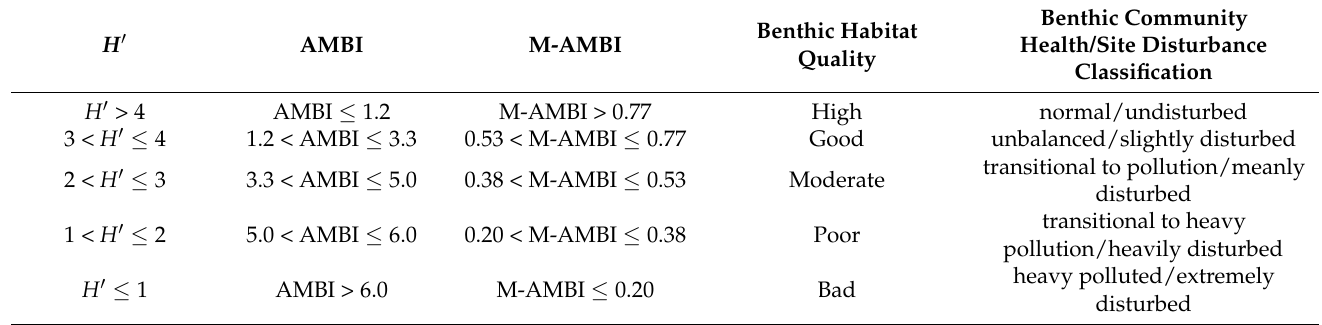
Table 1. The threshold levels of Shannon–Wiener index ( H (cid:48) ), and AMBI and M-AMBI indices for benthic habit quality